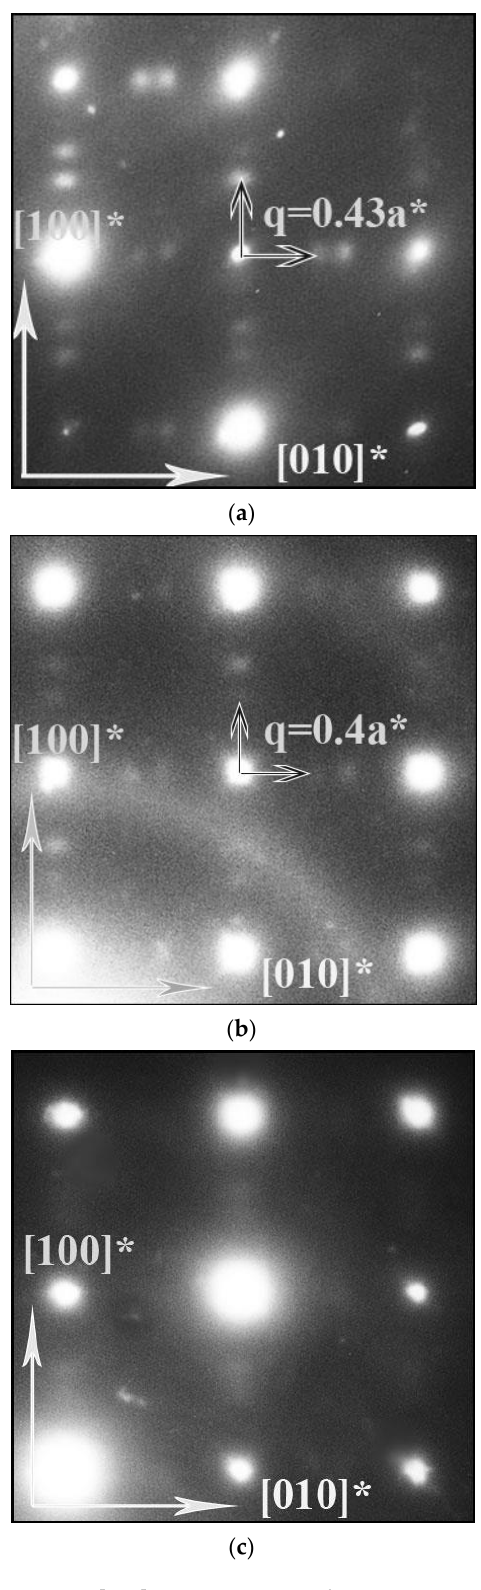
Figure 5. [001] SAED patterns of PrBaFe 2 O 6− δ in ( a ) — reduced, ( b ) — as-prepared state. ( c ) — [001] SAED pattern for as-prepared PrBa 0.5 Sr 0.5 Fe 2 O 6− δ . Positions of the diffuse reflections are shown by the incommensurate q vectors.